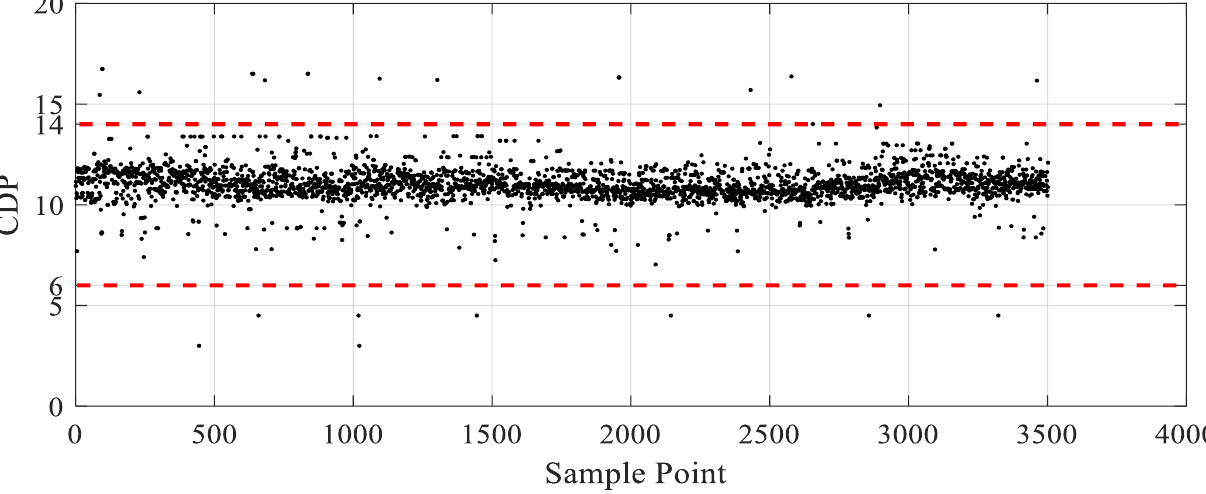
Figure 3. Scatter chart of NRCDPs between 2 and 19.99 Yuan. Table 3. The quantity of in different NRCDP range.